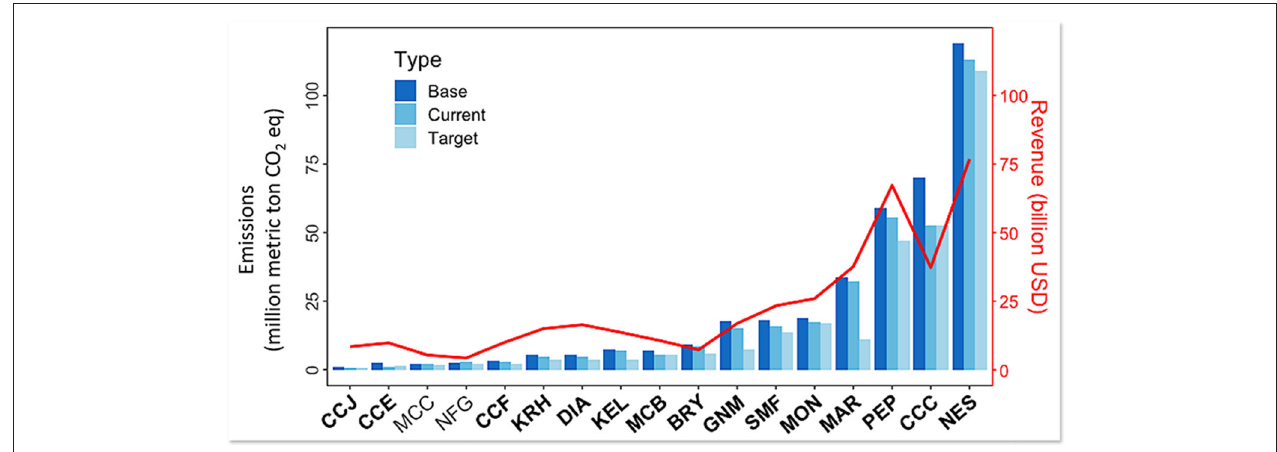
FIGURE 4 | Distribution of base year emissions, current (2020 report) emissions, and target year emissions for seventeen companies with absolute goals and emissions data for scopes 1, 2, and 3. Red line and y-axis correspond to 2020 food sales revenue for each company in billions of USD. Acronyms left to right with base and target dates: Coca-Cola Bottlers Japan (CCJ: 2015–2030), Coca-Cola European Partners (CCE:2019–2030), McCormick Corporation (MCC; 2015–2025), Nissin Foods Group (NFG: 2018–2060), Coca-Cola Femsa (CCF: 2015–2030), Kirin Holdings (KRH: 2015–2030), Diageo (DIA: 2007–2020), Kellogg Company (KEL: 2015–2050), Molson Coors Brewing Co. (MCB: 2016–2025), Barry Callebaut (BRY: 2018–2025), General Mills (GNM: 2010–2050), Smithfield (SMF: 2010–2025), Mondelez International (MON), Mars (MAR: 2015–2025), PepsiCo (PEP: 2015–2030), The Coca-Cola Company (CCC: 2015–2030), Nestle (NES: